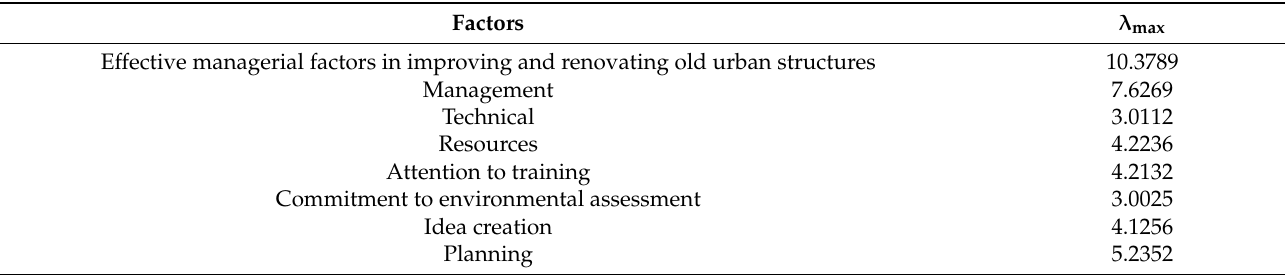
Table 26. The factors’ λ max .